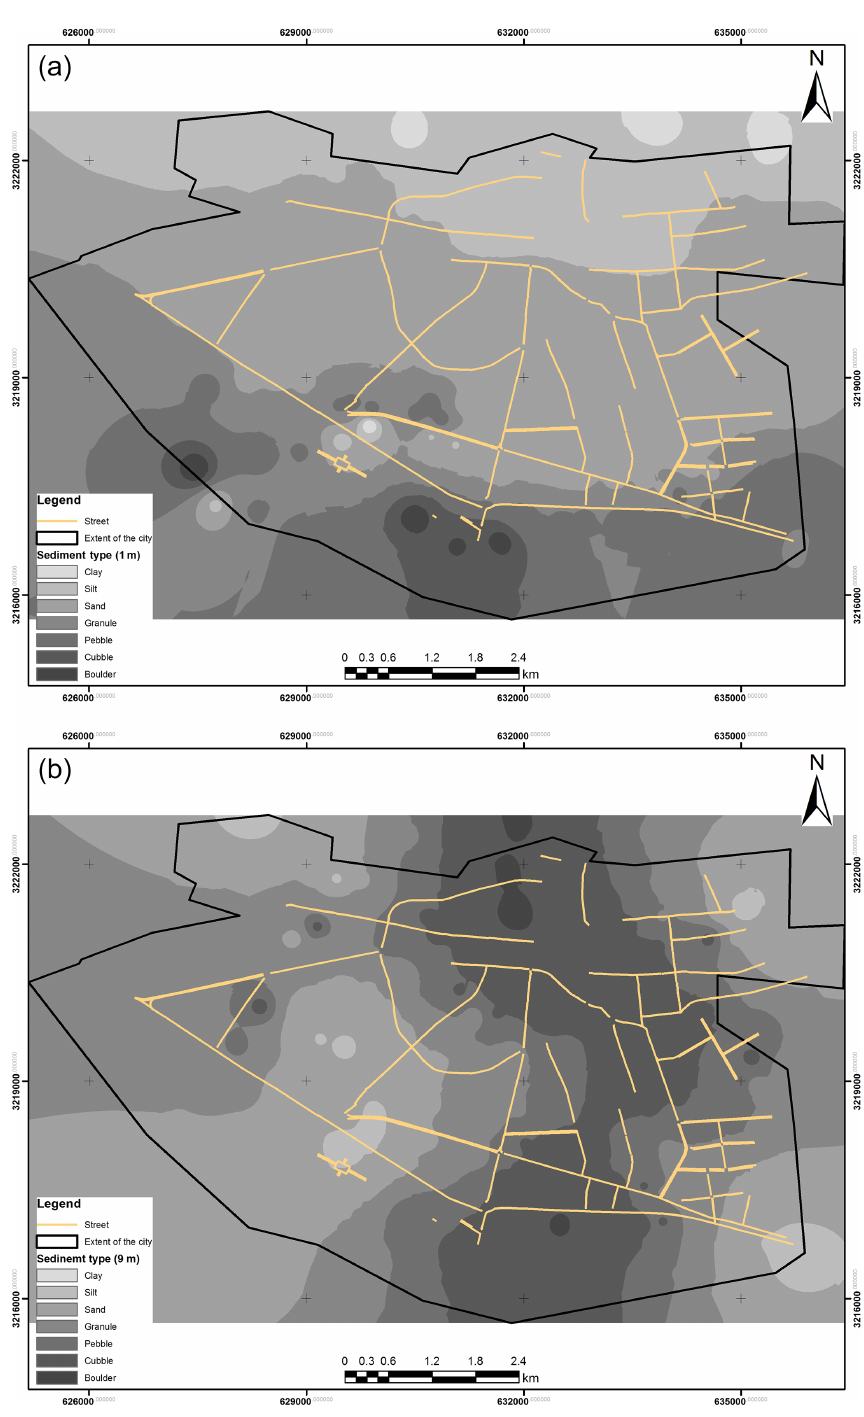
Figure 7. Thematic layers of Bam City: sediment type at a depth of 1m (a) and at a depth of 9m (b)